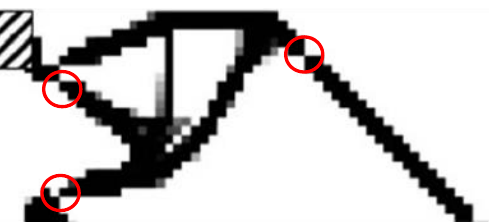
Figure 5. An optimal topology for a compliant gripper from F13 (Deepak et al., 2009).